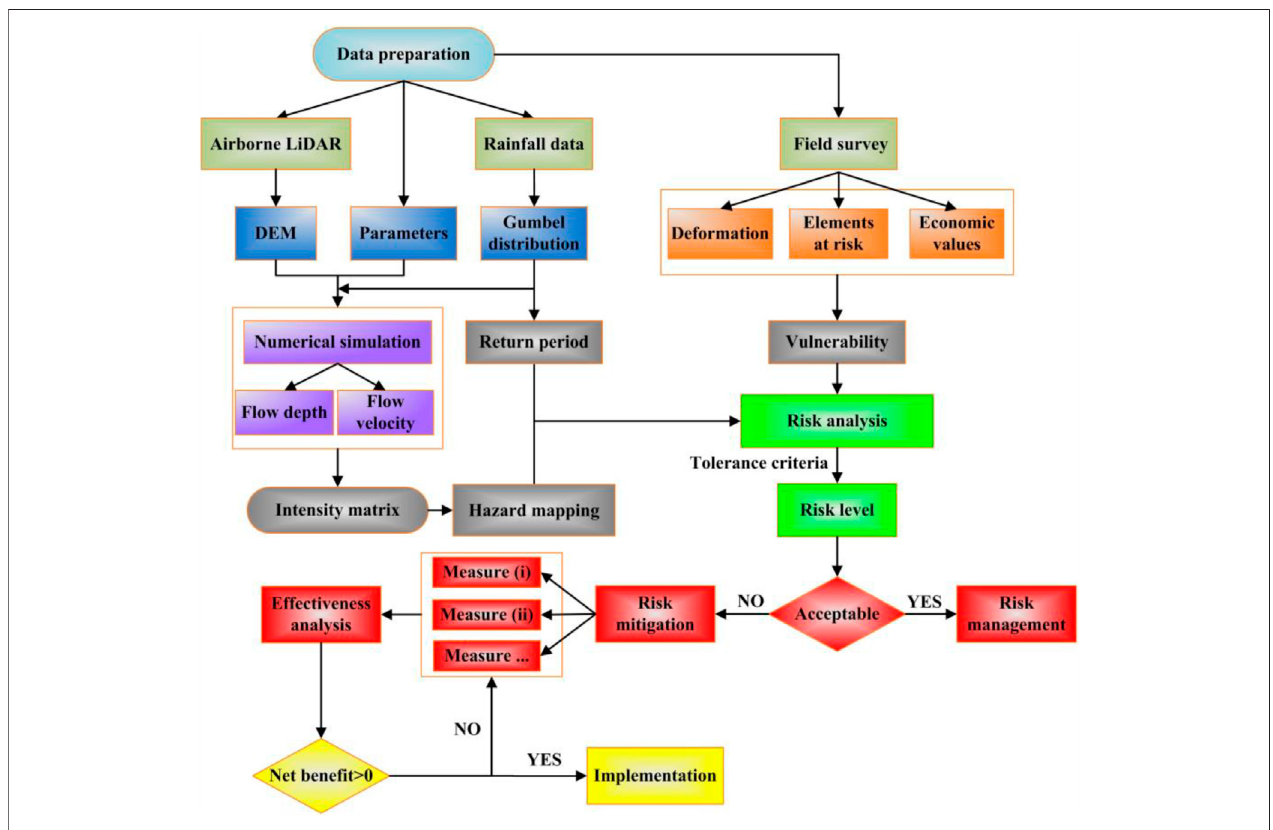
FIGURE 5 | Research strategy.